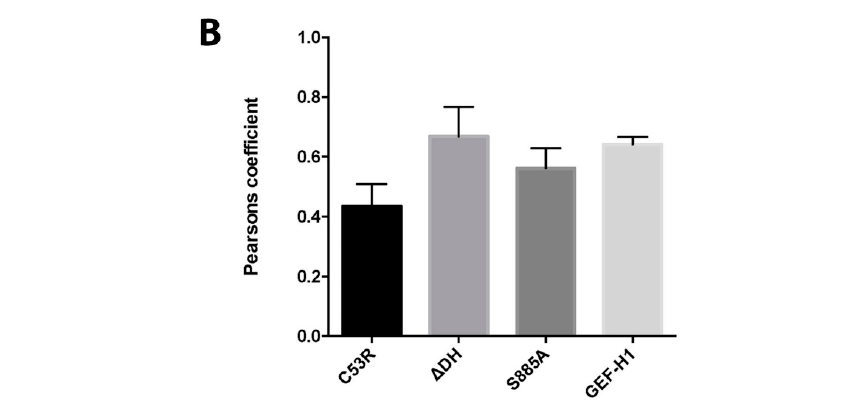
Figure 4. Expression of NS3 changes the location and morphology of the different GEF-H1 forms. ( A ) Vero cells were co-transfected with the HIS-tagged viral protein NS3 and the four different GEF-H1-GFP forms (WT, C53R, ∆ DH, S885A). The GFP signal of the different GEF-H1 forms is displayed in panels a, e, I, and m, while panels b, f, j, and n show the staining with the anti-6× HIS antibody. Panels c, g, k, and o show the merged image including the nuclear stain (DAPI). Panels d, h, l, and p represent the merged image of GEF-H1-GFP transfected but uninfected cells. Co-transfected cells displayed a dispersed morphology of GEF-H1 compared to cells transfected with the GEF-H1 forms only (panels d, h, l, and p). The co-localisation was quantified with the Pearson’s coefficient and is indicated in the merged image (panels c, g, k, and o). ( B ) Quantitation of the Pearson’s coefficients: C53R = 0.42 ± 0.19 ( n = 12), ∆ DH = 0.66 ± 0.18 ( n = 15), S885A = 0.60 ± 0.14 ( n = 17), and GEF-H1 = 0.65 ± 0.01 ( n = 19). Bars represent average ± SEM. Images were collected over triplicate experiments and analysed in GraphPad